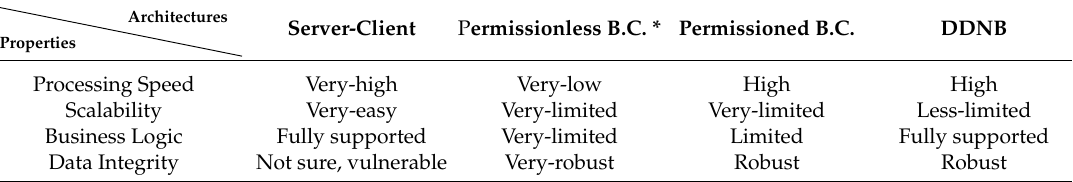
Table 1. Comparison of four different architectures’